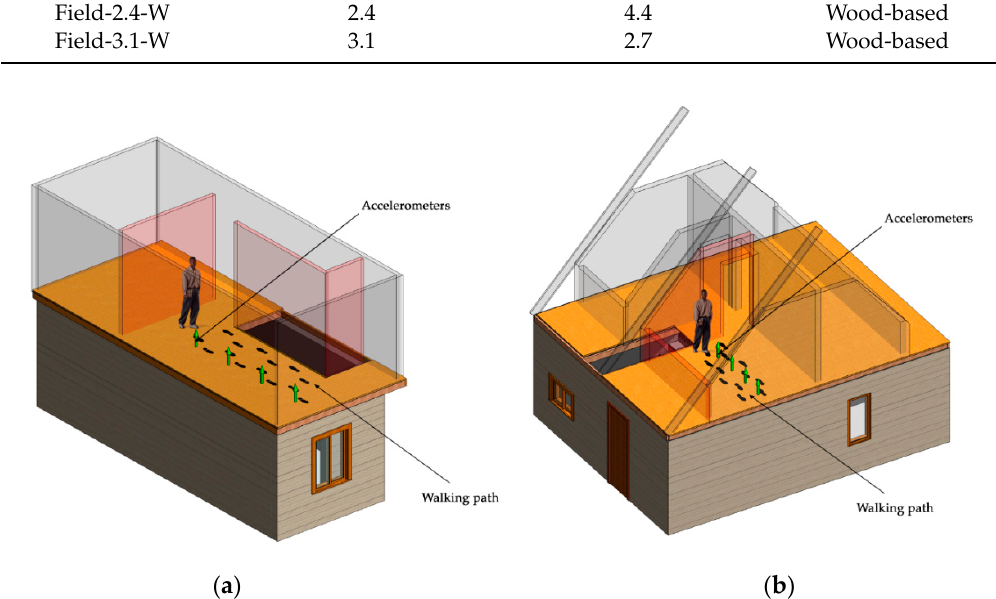
Figure 7. Walking paths and accelerometer locations on in-situ timber floors: ( a ) Field-2.4-W timber floor; ( b ) Field-3.1-W timber floor Table 3. Nomenclature, dimensions, and support details of in-situ timber floors.